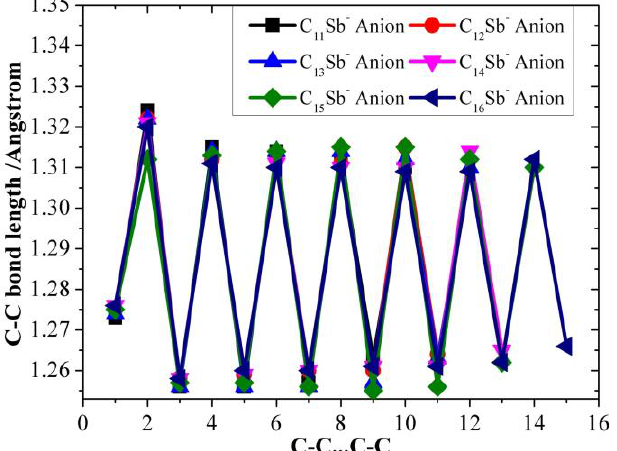
Figure 5. C-C bond length alteration of C n Sb − anions ( n = 11 – 16) as a function of number of carbon atoms.